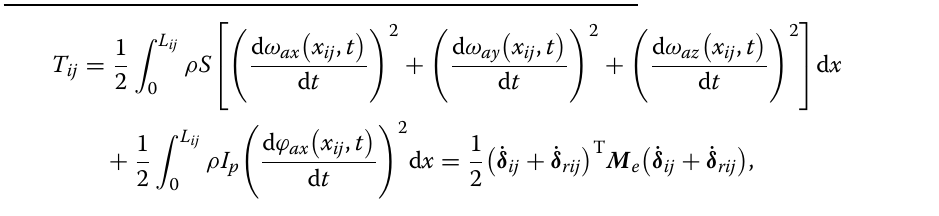
where x A ( B ) , y A ( B ) and z A ( B ) represent the rigid body dis- placements of the element nodes A ( B ) along the X -axis, Y -axis and Z -axis directions. θ x , θ y and θ z represent the rotation angle of the two element nodes around the X -axis, Y -axis and Z -axis.